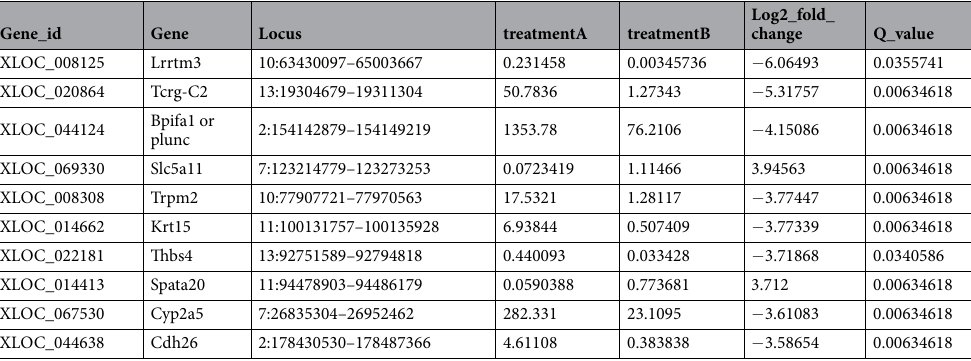
Table 1. The top 10 most significantly differentially expressed mRNAs, with log fold change (FPKM Log2_FC) between groups treatmentA (miR-200b + / + ) and treatmentB (miR-200b − / − ) with Benjamini-Hochberg FDR corrected q-values.